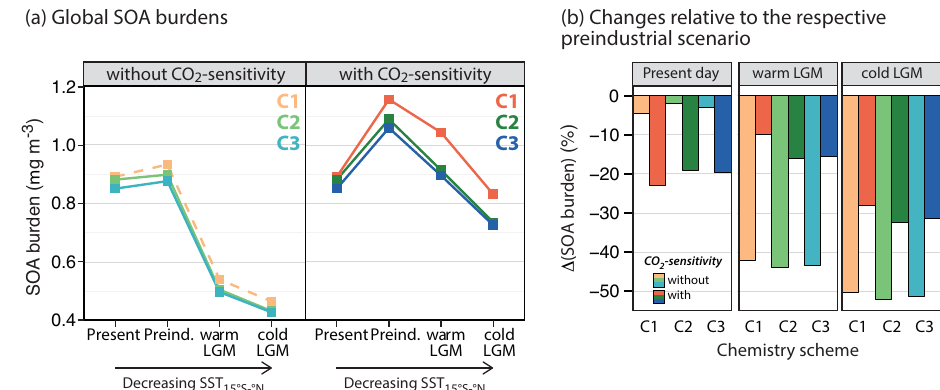
Figure 6. (a) Tropospheric mean mass-weighted secondary organic aerosol (SOA) burdens for each combination of climate, chemistry and plant isoprene emission scenarios. Simulations are as described in Table 2; colors are as in Fig. 2. The dotted light-orange line represents the results reported in Murray et al. (2014) for their “best estimate” lightning and fire emissions scenarios. (b) Percent changes in tropospheric mean SOA burdens relative to their respective preindustrial scenarios (e.g., C1-w present day relative to C1-w preindustrial). Colors are as in Fig.